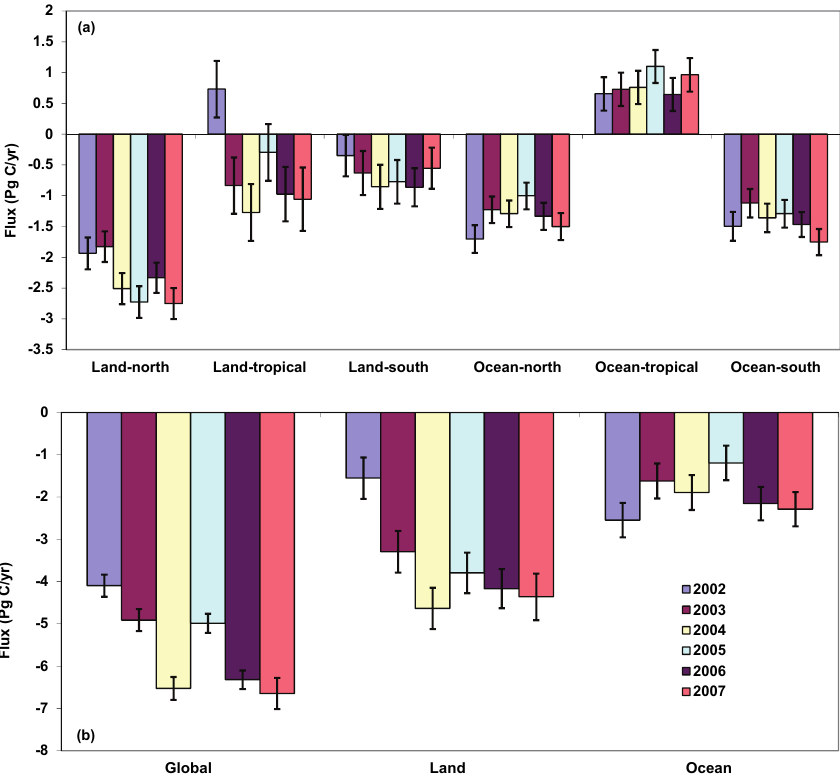
Fig. 5. Aggregated inverted CO 2 fluxes and their uncertainties from 2002 to 2007 (a) in Northern Land, Tropical Land, and Southern Land, and in Northern Ocean, Tropical Ocean, and Southern Ocean, and (b) of global total, total land, and total